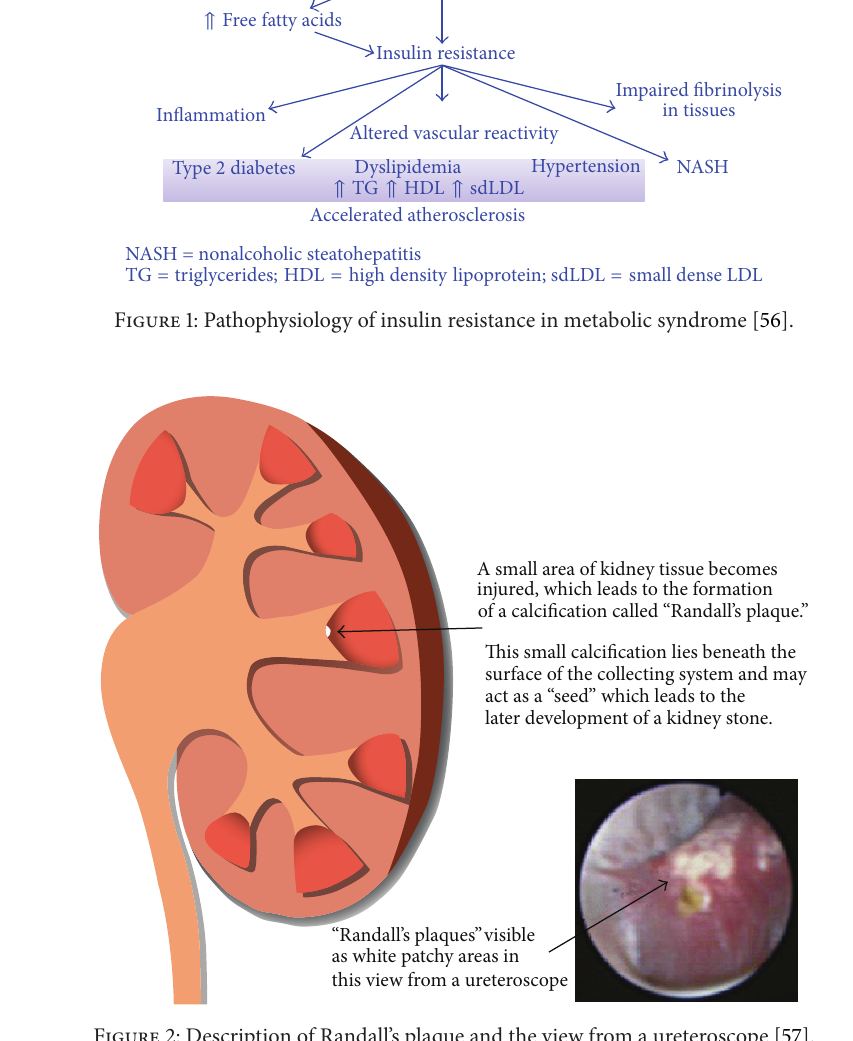
Figure 2: Description of Randall’s plaque and the view from a ureteroscope